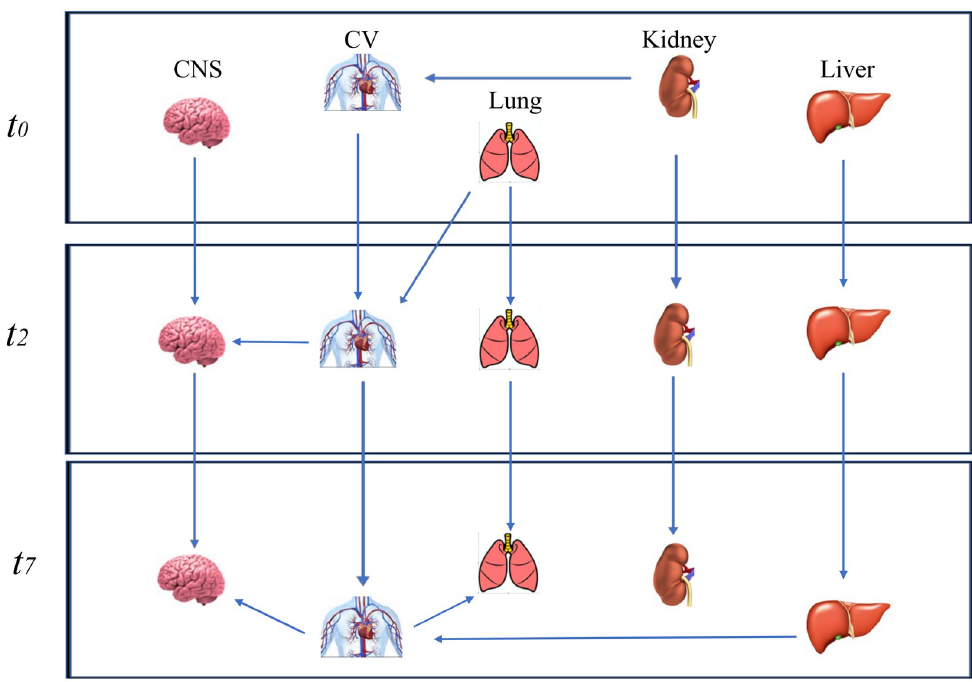
Fig 1. Dynamic Bayesian network excluding the coagulation node. The Dynamic Bayesian network without the coagulation node (C) at three time points ( t0 = the day of ICU admission; t2 = 2nd day and t7 = 7th day) after bootstrapping.